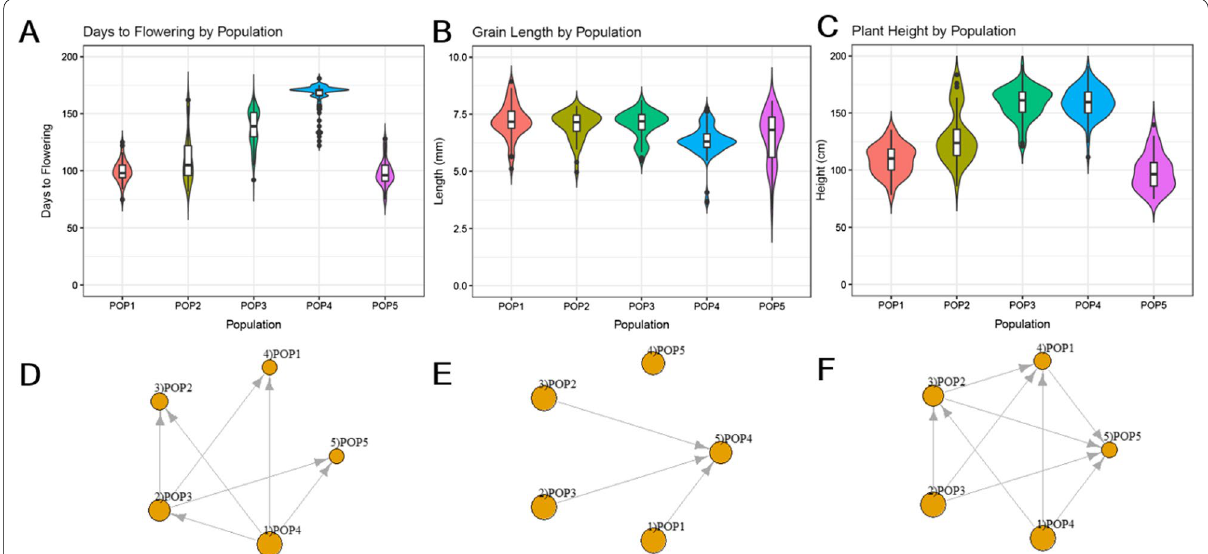
Fig. 4 Subpopulation distributions of three phenotypes: days to flowering ( A ), grain length ( B ), and plant height ( C ). Domination graphs represent relationships between pairs of populations for days to flowering ( D ), grain length ( E ), and plant height ( F ). Arrow directions point from the population with a significantly higher phenotype value to the population with a lower phenotype value (with Mann Whitney test at α = 0.001